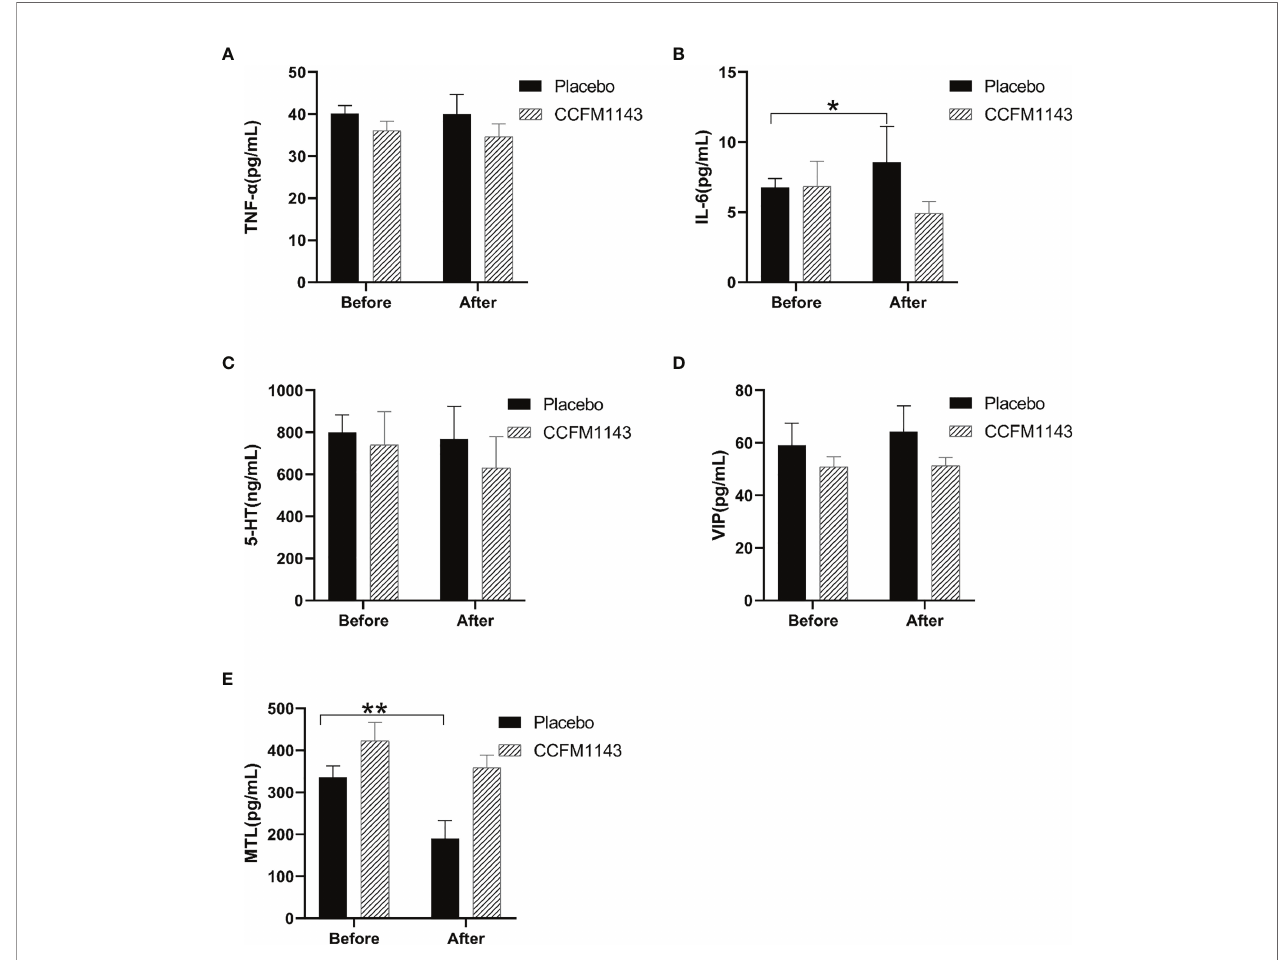
FIGURE 2 | Effect of Lactobacillus plantarum CCFM1143 on serum neurobiological factors, cytokines, and motilin (MTL) in patients with diarrhea. (A – E) Concentrations of tumor necrosis factor alpha (TNF- a ) (A) , interleukin-6 (IL-6) (B) , 5-hydroxytryptamine (5-HT) (C) , vasoactive intestine peptide (VIP) (D) , and MTL (E) . * p < 0.05, ** p <